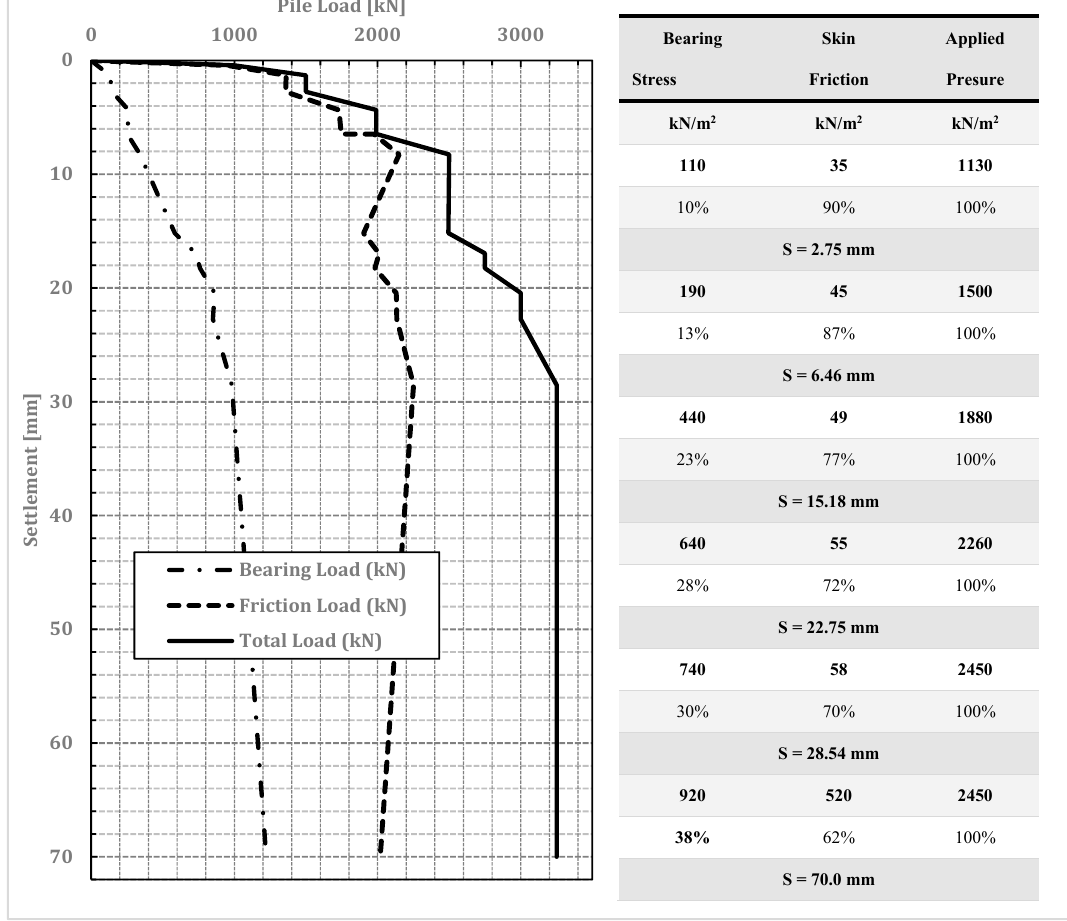
Figure 2. In situ measurements of the well-instrumented large diameter bored pile (Modified from [12]).